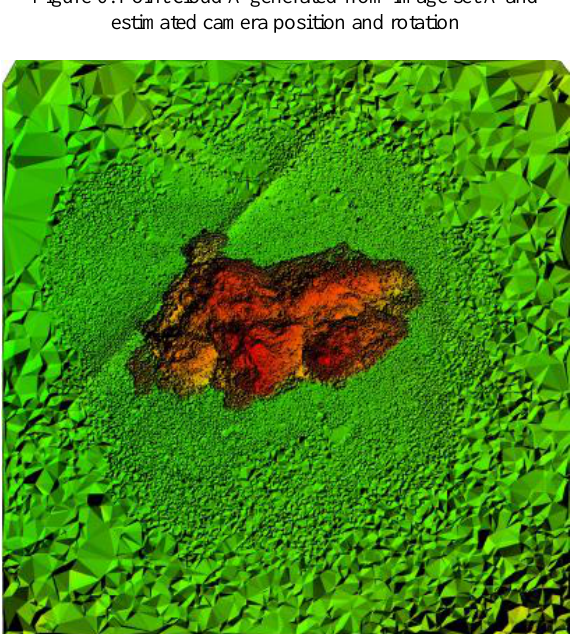
Figure 7. DSM created from the point cloud